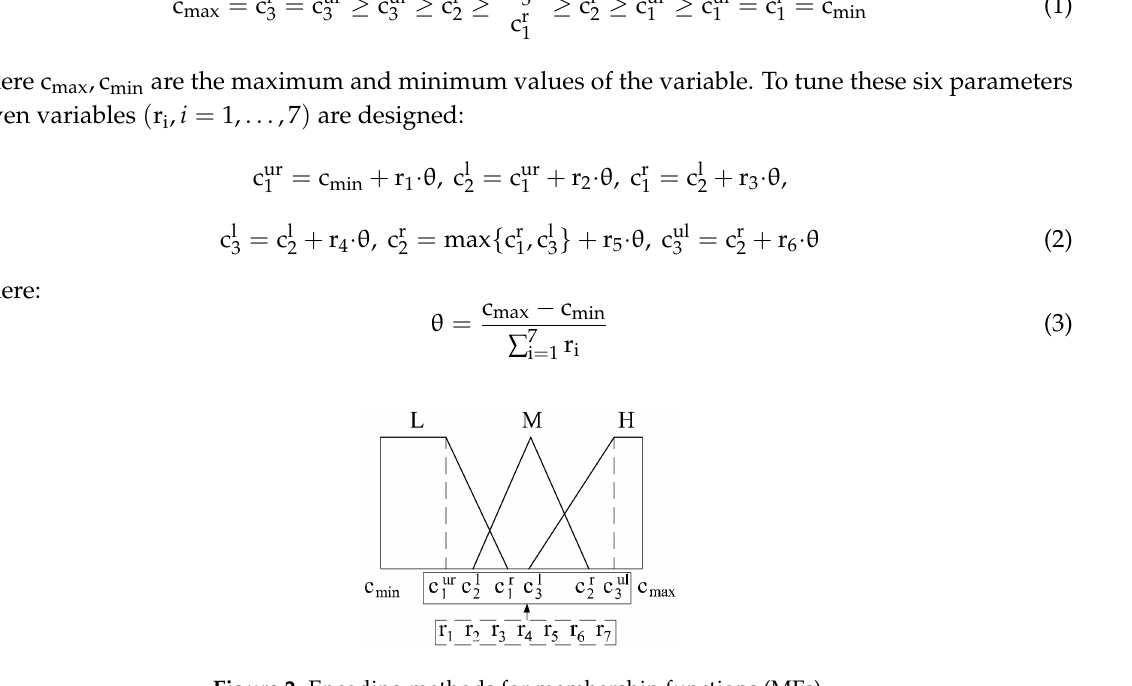
Figure 2. Encoding methods for membership functions